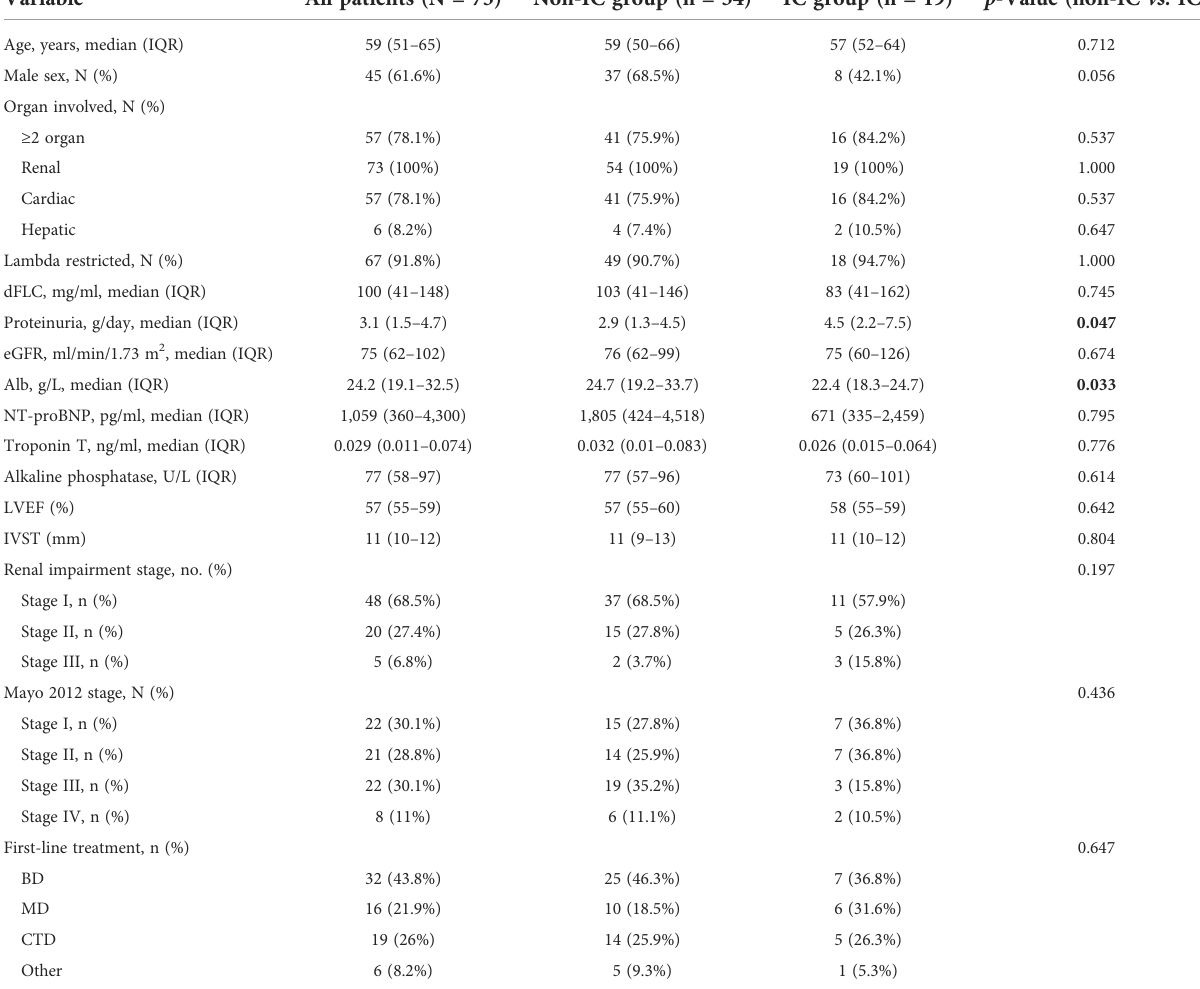
TABLE 2 Baseline characteristics between the IC group and the non-IC group.